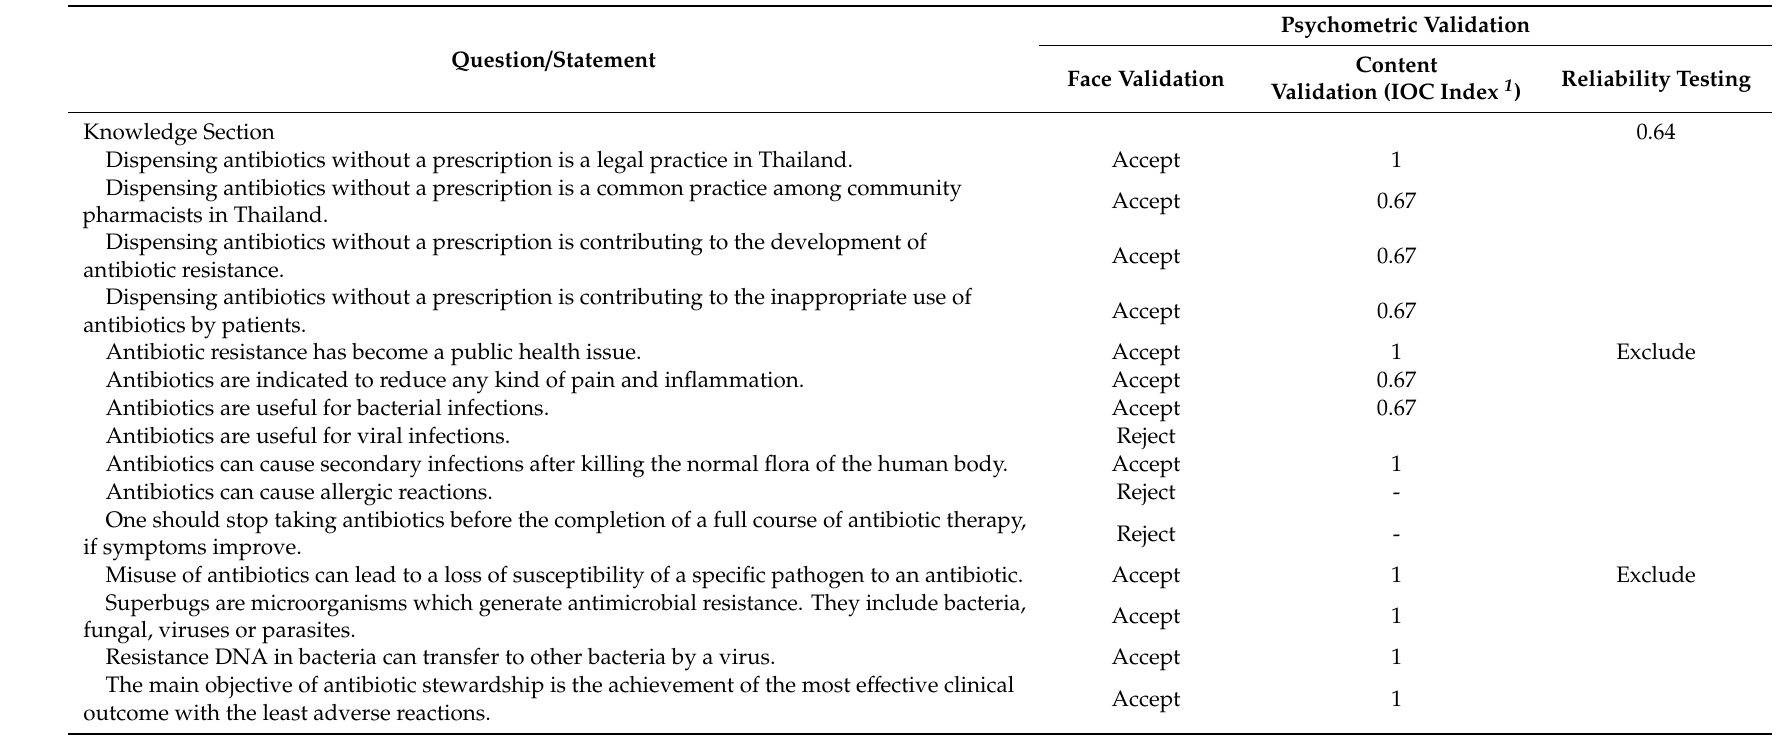
Table 1. Lists of Items of Knowledge Domain of the Survey